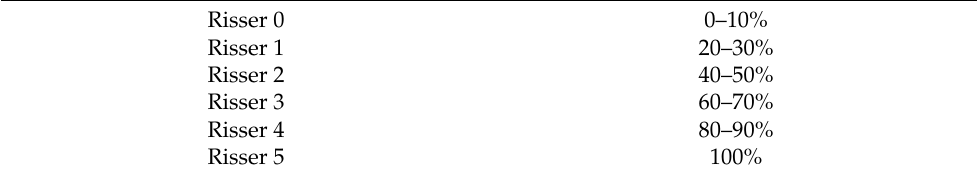
Table 1. Reference diagram in percentages to illustrate the intermediate Risser